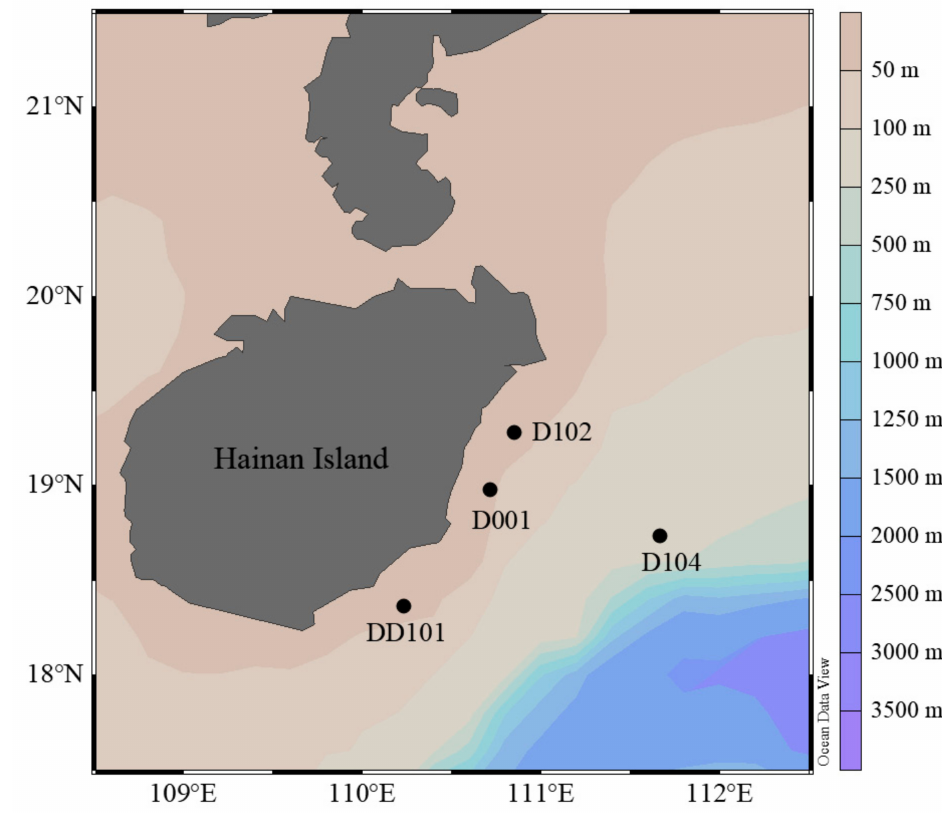
Figure 1. Location of the sampling stations in eastern Hainan Island during